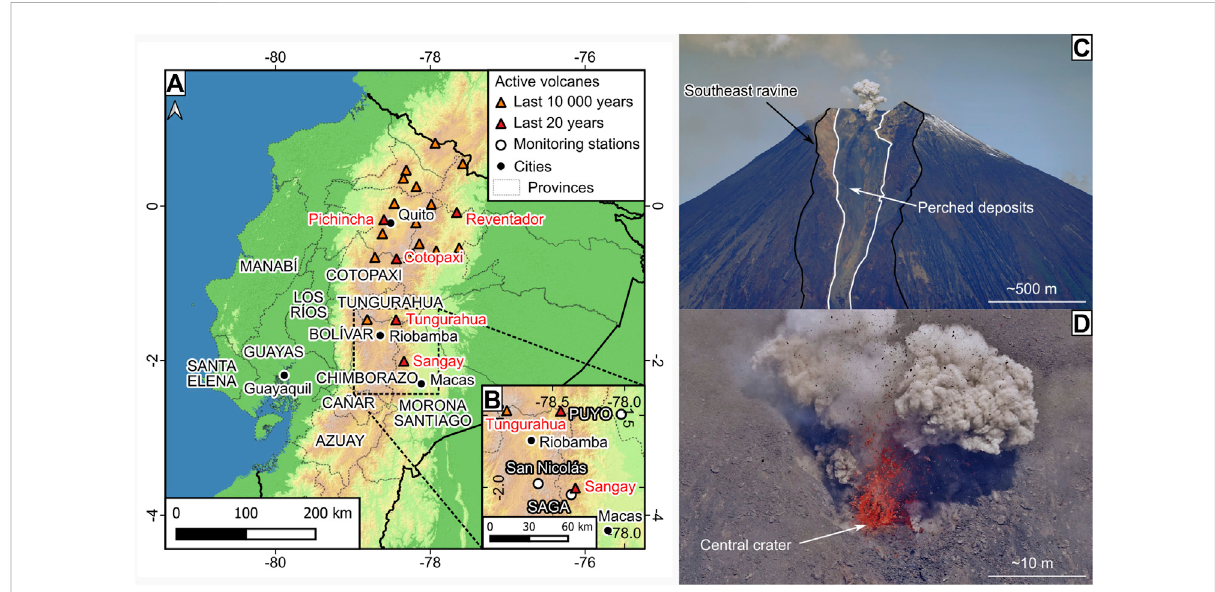
FIGURE 1 General map and photos of Sangay volcano. (A) General map of active Ecuadorian volcanoes (data source: Digital Elevation Model FABDEM; VolcanoesandMonitoringstationsIG-EPN;CitiesandProvincesIGM;WGS84); (B) CloseuptotheSangayareaandthemonitoringnetworkin2020; (C) view of Sangay volcano from the Southeast with focus on the southeast ravine (December 27, 2021); (D) Strombolian explosion in the central crater from Sangay volcano (December 27,